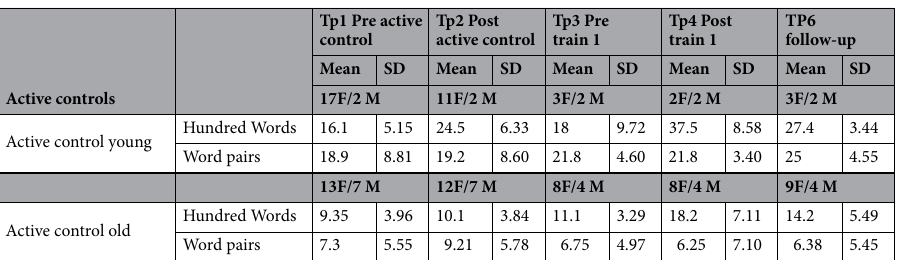
Table 5. Scores on the hundred words task (criterion task) and the word pair task (transfer task) of young and older active control groups at all time points, separated by group allocation according to the ABAB/BABA